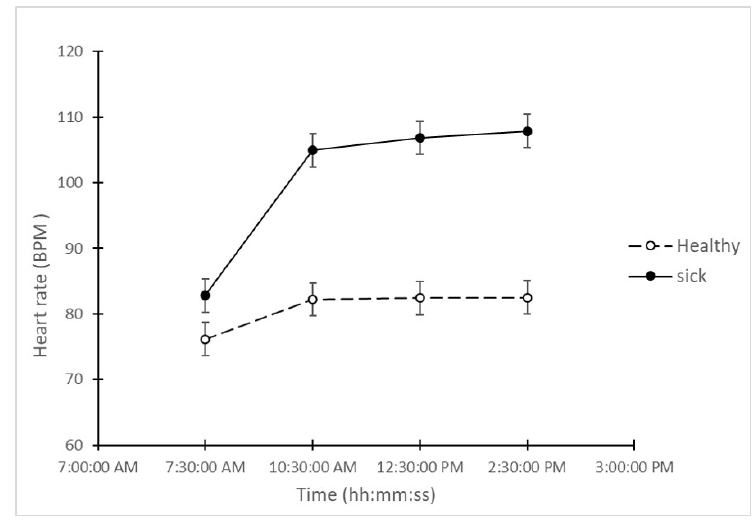
Figure 3. Average measurements of heart rate (beats per minute) in “sick” and “healthy” animals at all 4 time points on the day after the challenge.